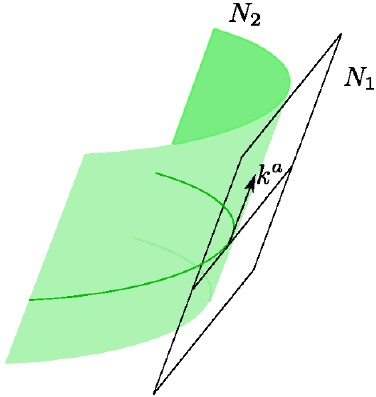
Figure 4 . The lines depict tangent spacelike cuts of null congruences N 1 and N 2 . N 2 is nowhere to the past of N 1 and is thus expanding faster by lemma